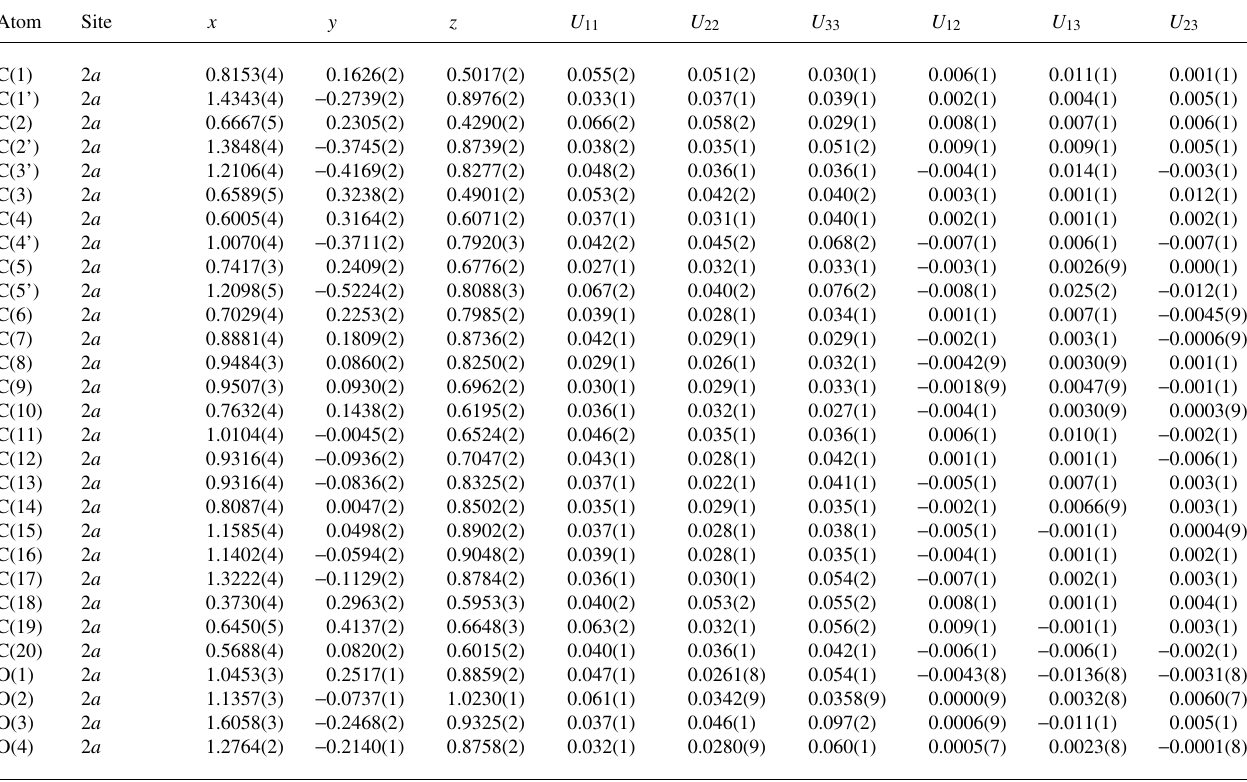
Table 3. Atomic coordinates and displacement parameters (in Å 2 )